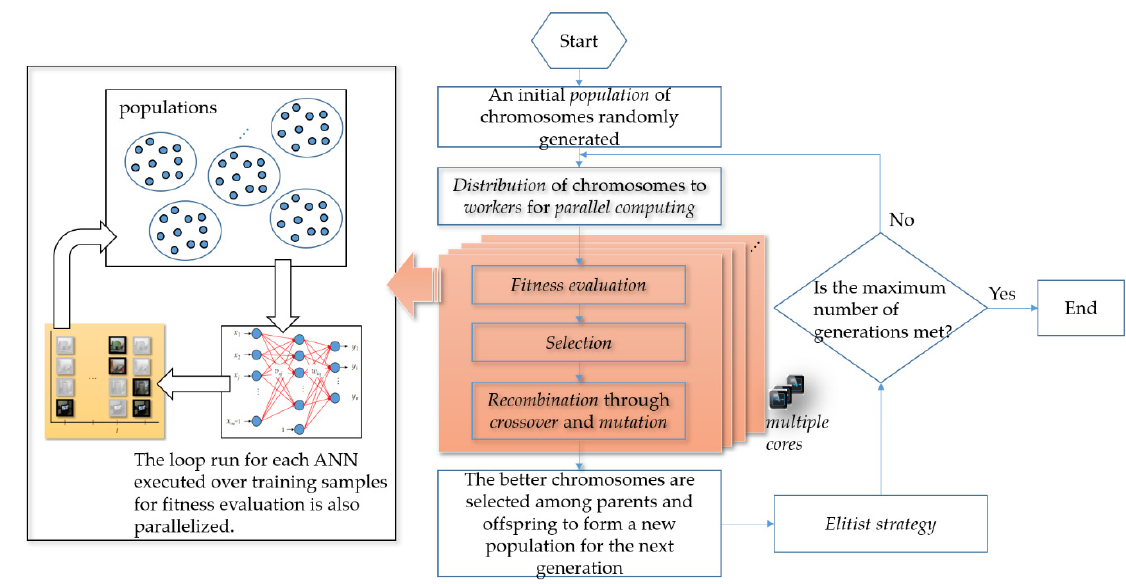
Figure 7. Flowchart of a parallel GA used to evolve an ANN for NILM in this work. In the GA, function evaluations/routines are farmed out to different processors. They are done simultaneously.